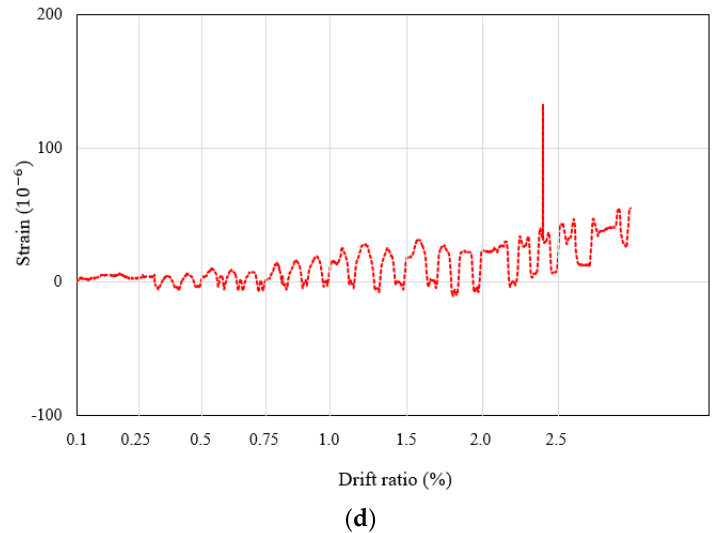
Figure 11. Strain at the end of the column: ( a ) strain of the concrete at the end of the column, ( b ) strain of the longitudinal steel at the end of the column, ( c ) strain of the transverse steel at the end of the column, and ( d ) strain of the CFST frame at the end of the column.